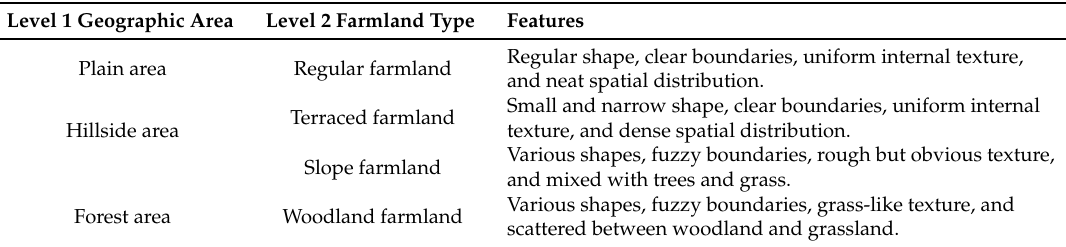
Table 3. The farmland classification